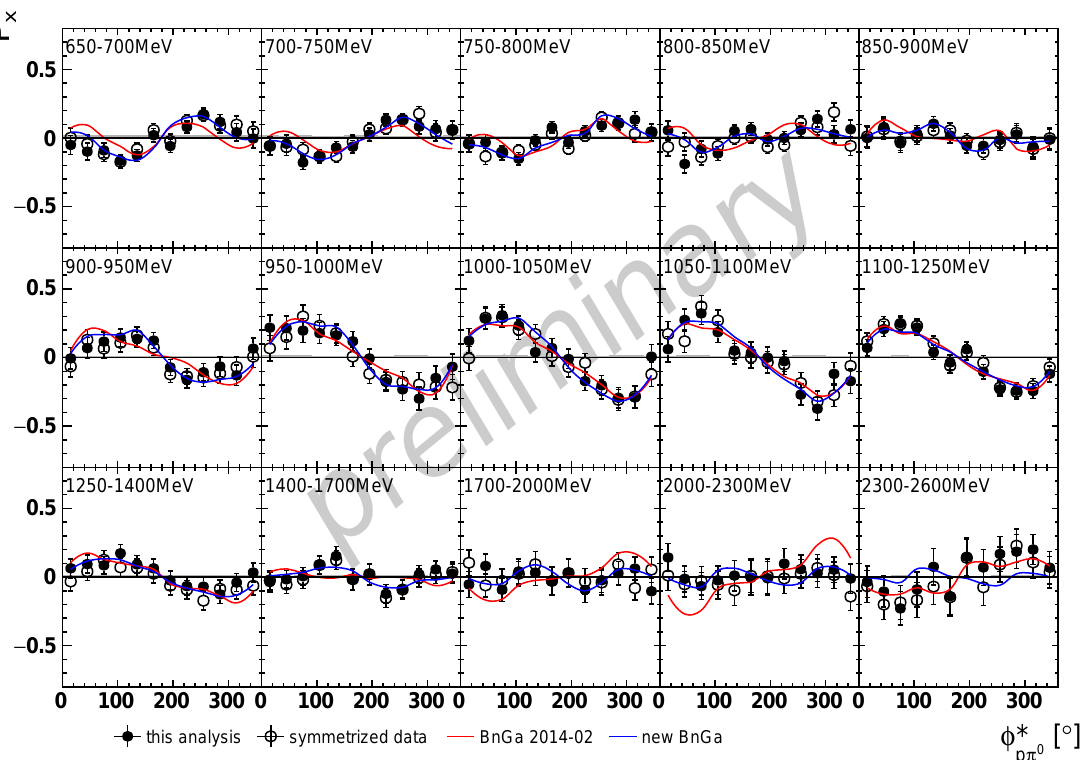
Figure 5. Targetasymmetry P x as a function of beam energy E γ and φ ∗